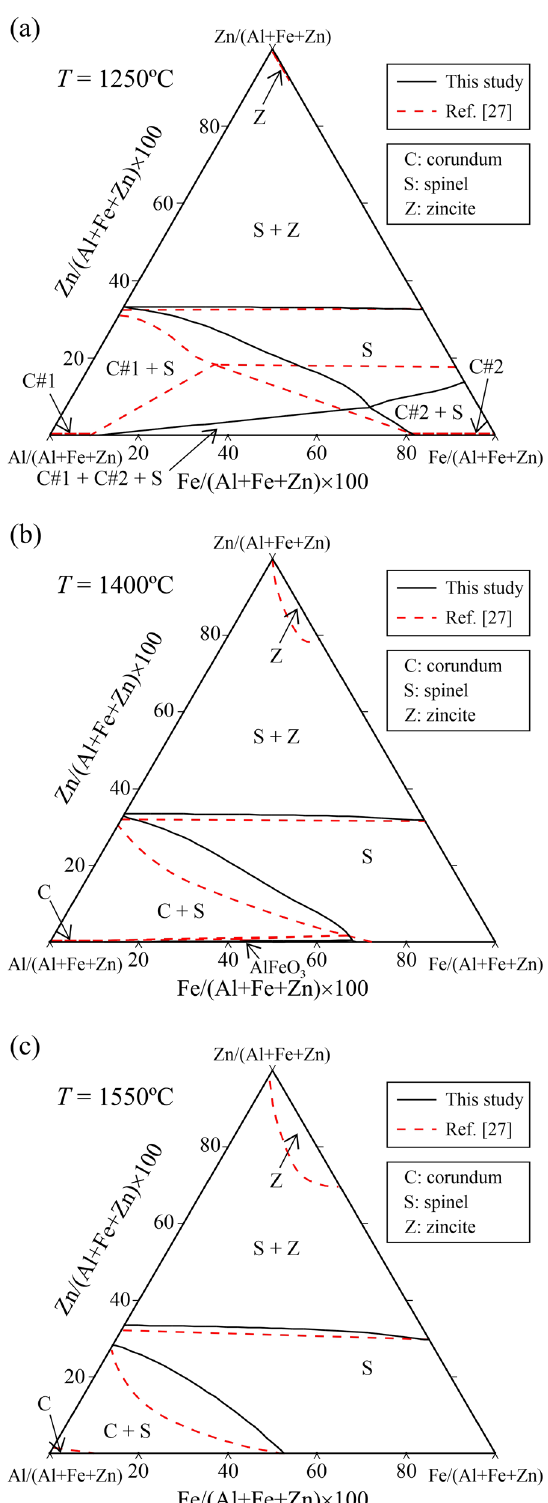
Figure 5: Calculated isothermal phase equilibria of the Al 2 O 3 – FeO – Fe 2 O 3 – ZnO region projected onto the Al – Fe – Zn ternary com - = 1 × 10 − 6 atmat ( a ) T = 1,200°C, ( b ) T = 1,300°C,and positiontriangle p O 2 ( c ) T = 1,400°C, together with the experimental results [ 54 ]